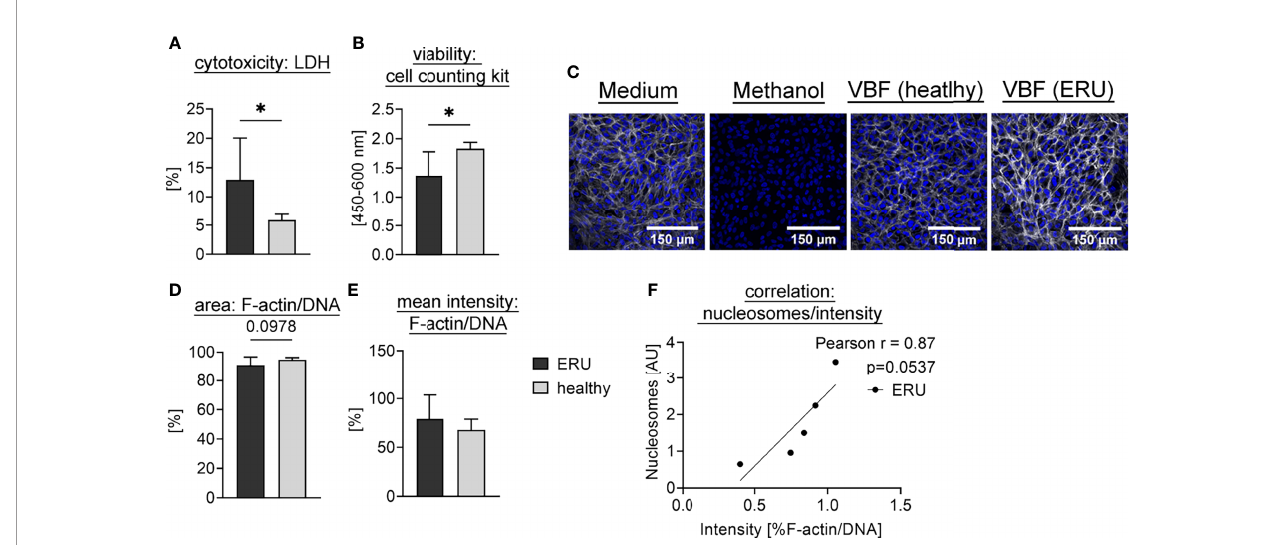
FIGURE 5 | Interaction of equine VBF with cells of the outer blood-retina barrier. Con fl uent ARPE-19 cells were exposed to VBF of fi ve ERU-diseased and fi ve horses with healthy eyes. For (A) , the cytotoxicity was measured using the amount of released LDH. The bars represent the mean ± SD. A one-tailed unpaired student ’ s t-test comparing healthy to ERU-diseased groups (n=5) revealed a signi fi cant difference. p values of * p < 0.05 were considered signi fi cant. (B) shows the viability of cells determined by cell counting kit-8. The bars represent the mean ± SD. Viability was signi fi cantly higher after incubation with healthy VBF samples compared to ERU samples. A one-tailed unpaired student ’ s t-test was performed. p values of * p < 0.05 were considered signi fi cant. In (C) , representative images of the cells after incubation with medium (DMEM:F12, 1% Penicillin-Streptomycin), methanol ( fi nal 70%), VBF of a horse with healthy eyes and VBF derived from an ERU patient are depicted. Confocal microscopy was performed after immuno fl uorescence staining [blue = DNA, white = F-actin]. In (D) , the area covered by F-actin in relation to nuclei was compared between the groups, whereby no difference could be observed. In (E) , an increase in the ratio of F-actin to DNA in RPE cells incubated with VBF of ERU patients was detected. For (D, E) , six randomly selected images per sample (n=5 per group) were evaluated. The bars represent the mean ± SD. One-tailed unpaired student ’ s t-tests were performed. In (F) , the nucleosome values of the ERU samples show an almost signi fi cant correlation to the according intensity ratio. A two-tailed Pearson correlation was performed, and the scatter plot including the simple linear regression line is